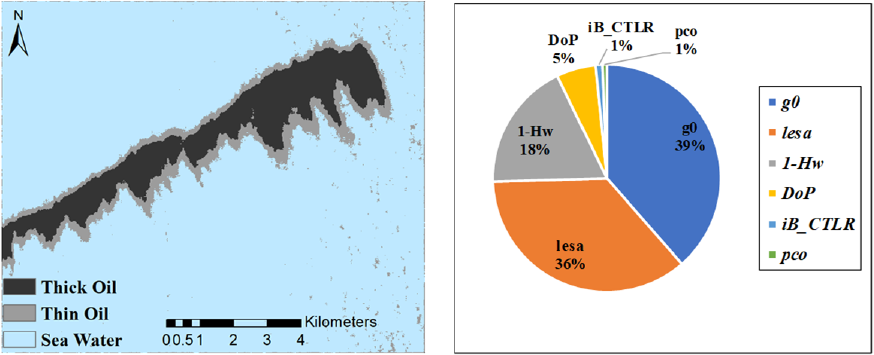
Figure 18. Random forest classification result graph and variable importance ranking for Case 5.